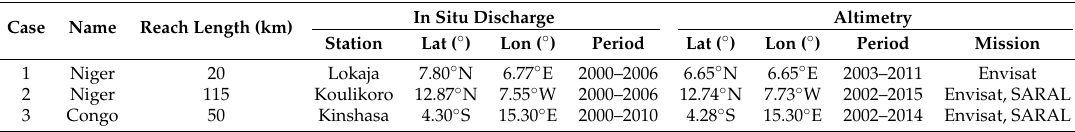
Table 2. Information about case studies and